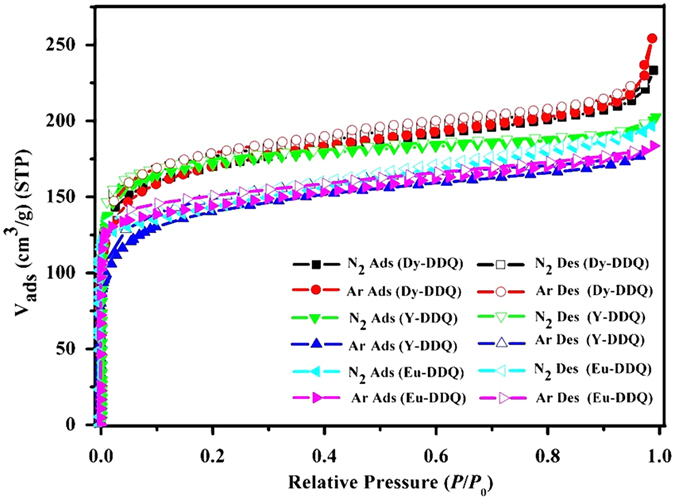
N2 and Ar adsorption isotherms for Y-DDQ, Dy-DDQ and Eu-DDQ.